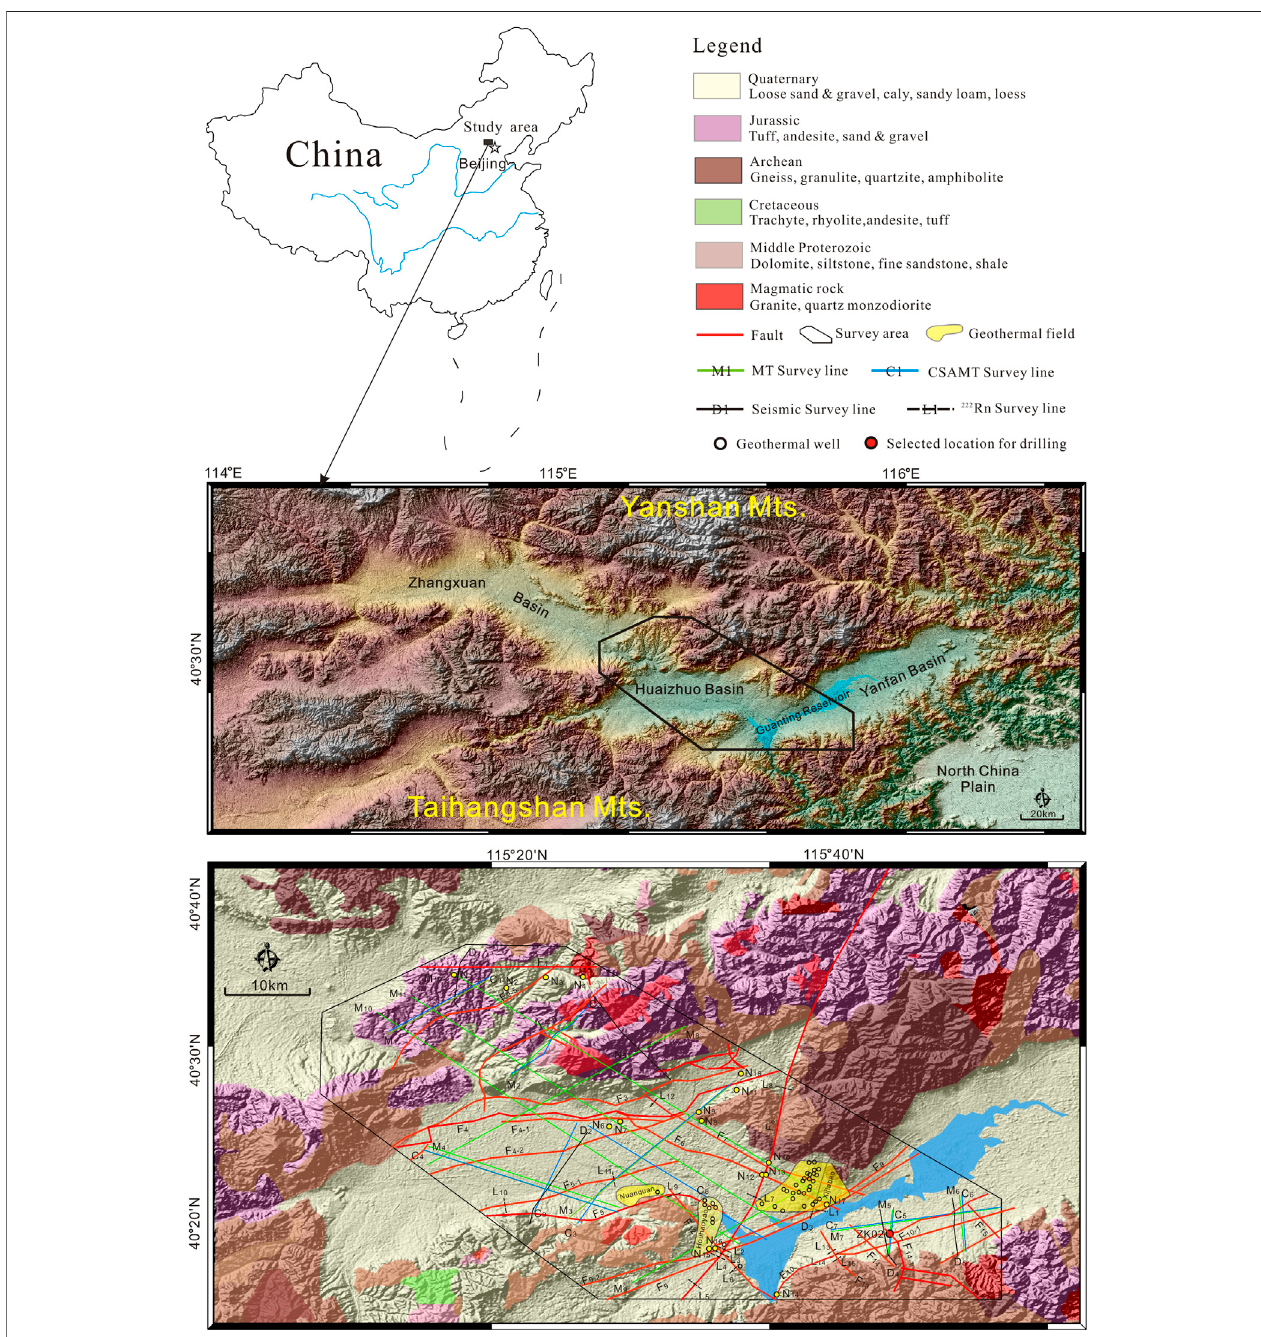
FIGURE 1 | Schematic geological map and location of fi eld survey lines of the study area.